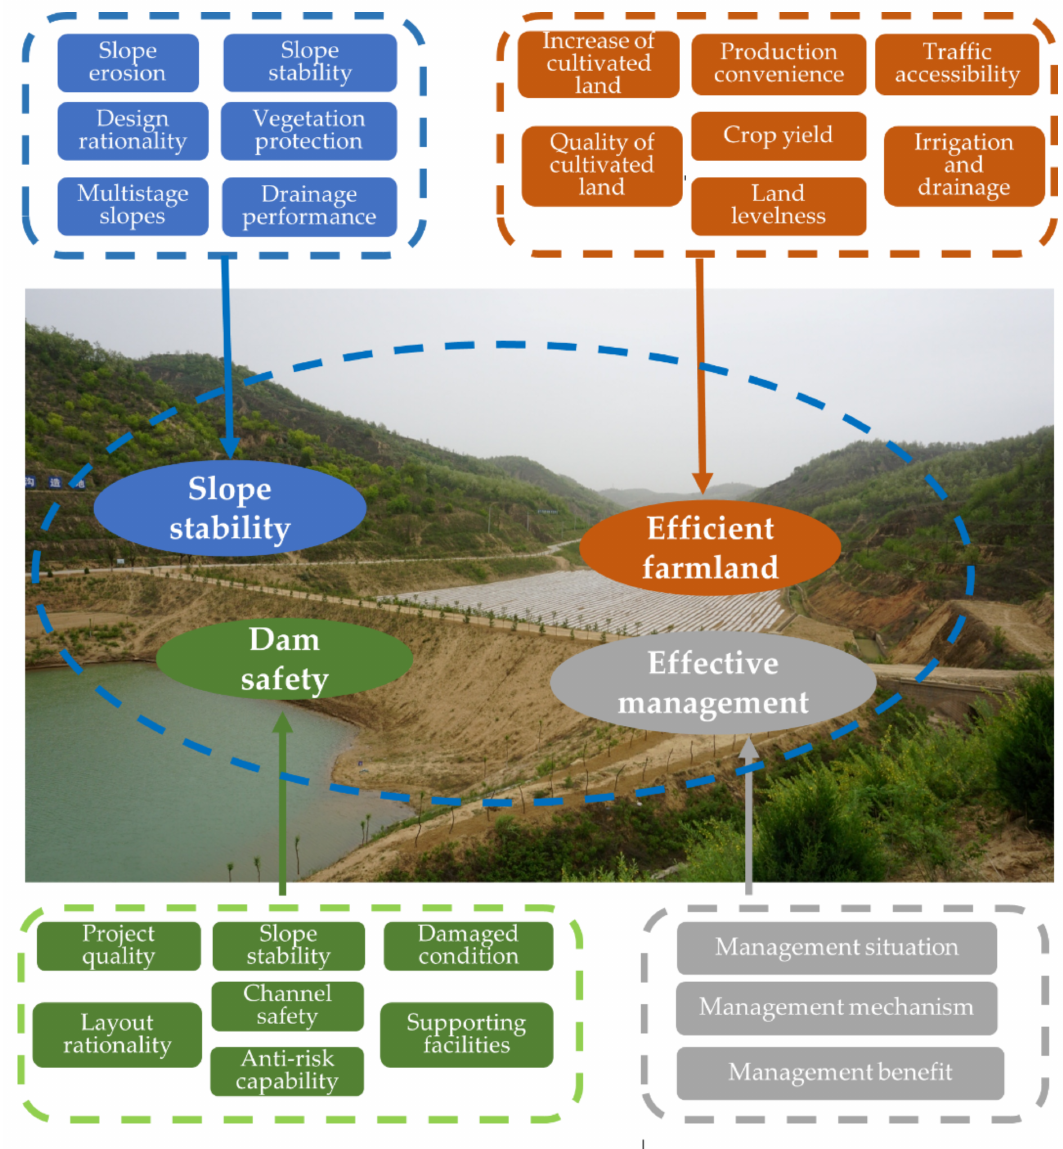
Figure 2. Index selection of ecological security effects and its main